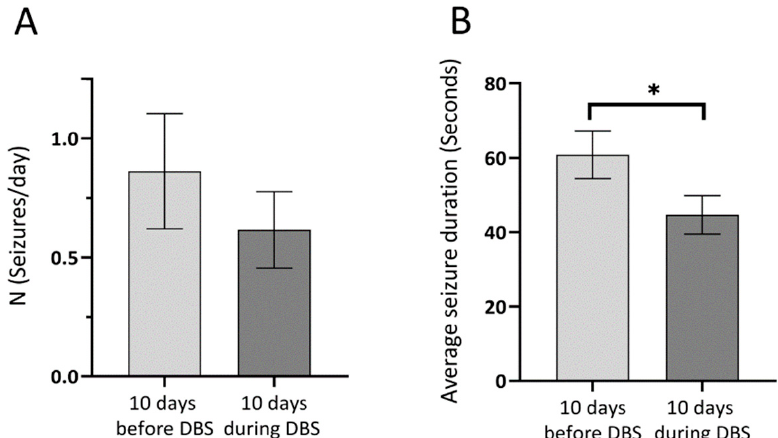
Figure 2. The effect of deep brain stimulation (DBS) on seizure rate and duration during the early chronic phase of the epilepsy, before and during the stimulation. ( A ) Seizure rate (seizures / day) 10 days before and during the 10 days DBS period ( n = 10). A 23% decrease in seizure frequency was present. ( B ) Average seizure duration 10 days before and 10 days during DBS. A significant reduction in seizure duration can be observed during DBS. Data are presented as mean ± SEM, * p <